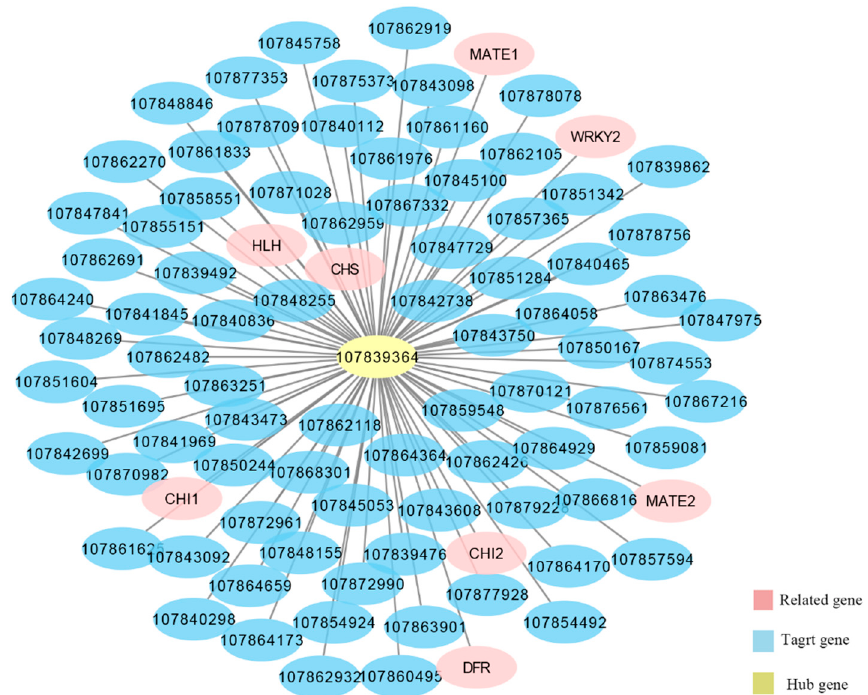
Figure 8. Co-expression network analysis of the hub genes. Take 107839364 with the best connectivity in the brown module as the central gene, and the network structure diagram of all genes with a significant difference ( q < 0.05) and edge weight ≥ 0.25 in the brown module.